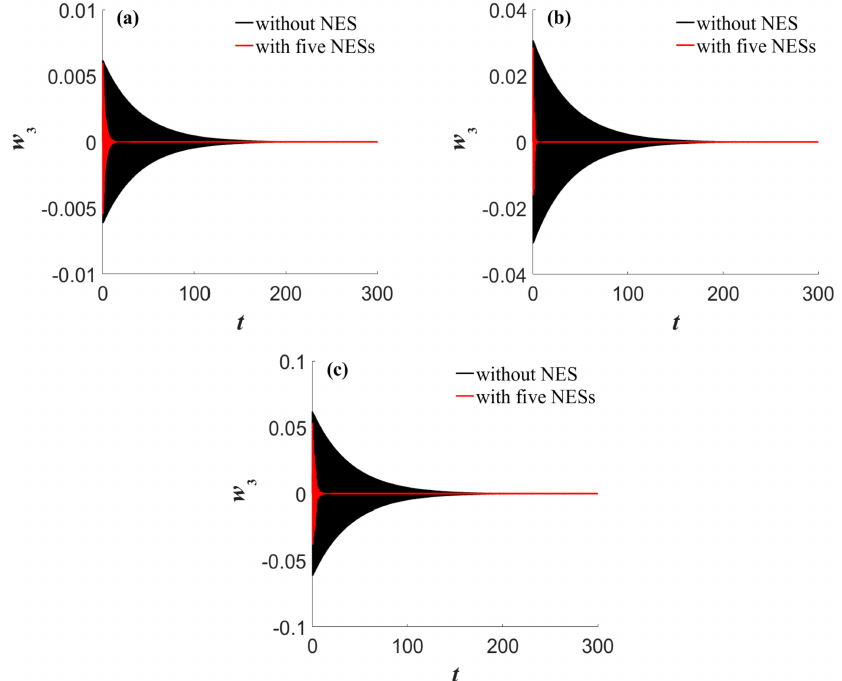
Figure 10. The third-order transient response of sandwich plate under different excitation. Ampli- tudes: ( a ) f = 1; ( b ) f = 5; and ( c ) f =